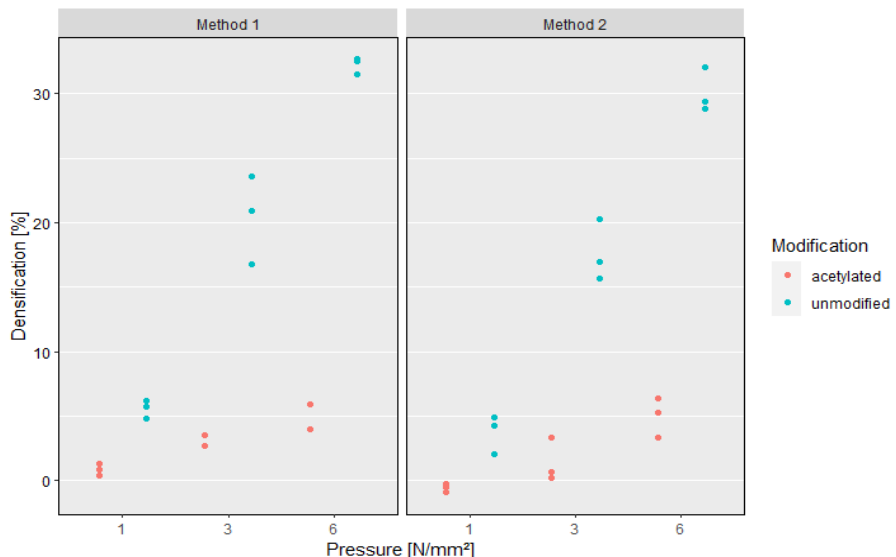
Figure 1. The compression ratio of acetylated and non-acetylated beech LVL was measured using two methods, as described in Section 2. The fact that method 2 exhibited negative compression at 1 MPa whereas method 1 did not could be attributed to the second approach’s missing adhesive film thickness (see method 2 in Section